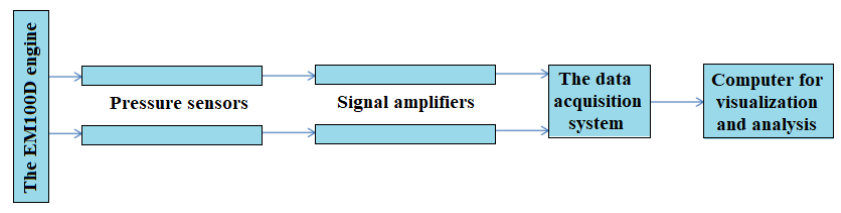
Figure 3. The scheme of the data acquisition and processing system.